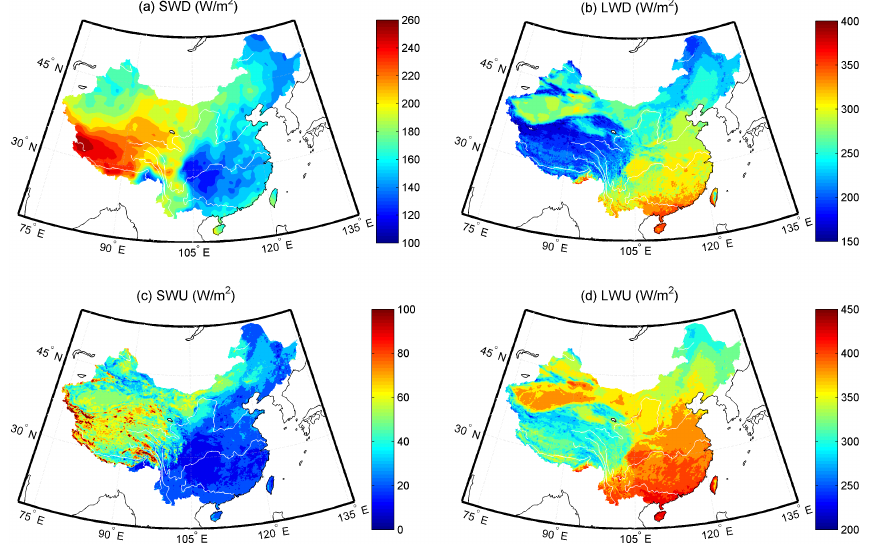
Figure 7. Maps of annual average (a) downward short-wave radiation (SWD), (b) downward long-wave radiation (LWD), (c) upward short- wave radiation (SWU), and (d) upward long-wave radiation (LWU) from 2001 to 2010. Black lines show several major rivers in